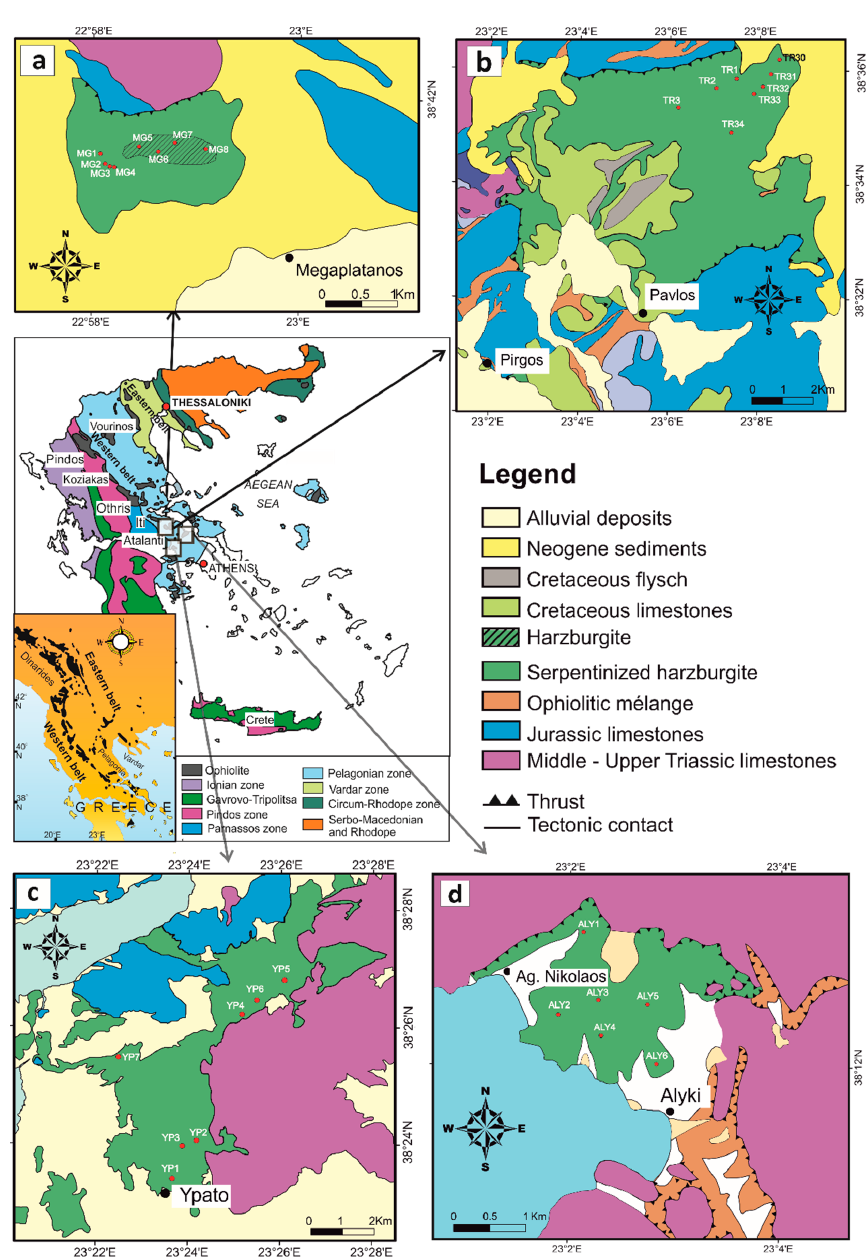
Figure 1. Geological maps with the sample locations of ( a ) Megaplatanos; ( b ) Tragana; ( c ) Ypato; and ( d ) Alyki ophiolites. Inset shows a simplified geological map of Greece with the main isopic zones and the distribution of ophiolite occurrences in Balkan Peninsula.